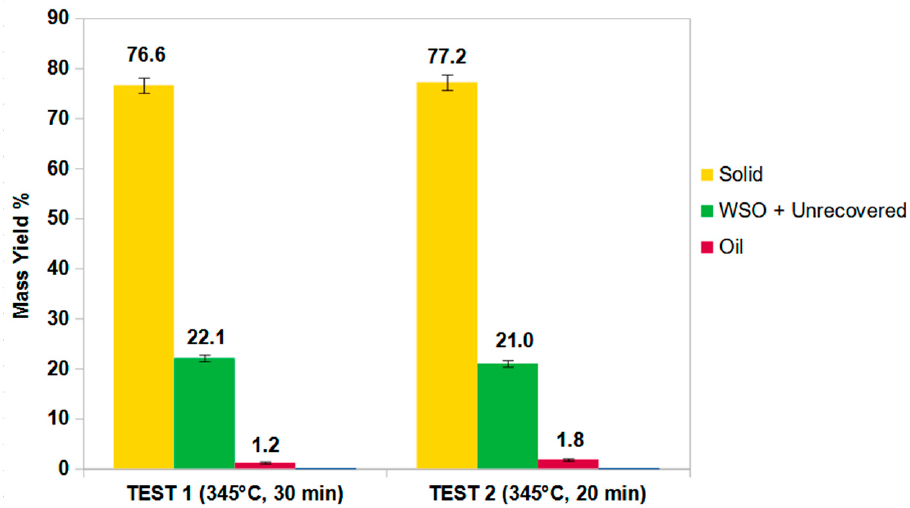
Figure 5. Yields with relative error from the two tests at 345 °C with different residence time. As can be seen, a 10 min reduction in the reaction time does not lead to significant differences in product yields, resulting in significant energy savings. In both processes, the solid fraction is the majority product with a yield of over 76%. Considering the heterogeneity of the sample and therefore the variable quantity of PET for each test, the yields of the two processes are comparable. Gas formation was not revealed during the experiments. This agrees with the data in the literature in which noncatalyzed processes always generate small quantities of gas